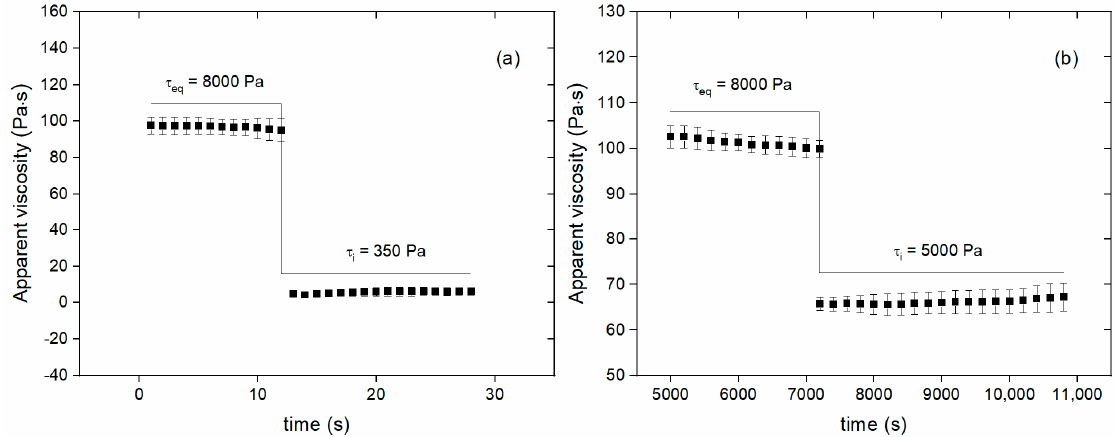
Figure 8. Time response of apparent viscosity to a step down in shear stress. The initial shear stress corresponds to 8000 Pa. ( a ) τ = 350 Pa; ( b ) τ = 5000 Pa.